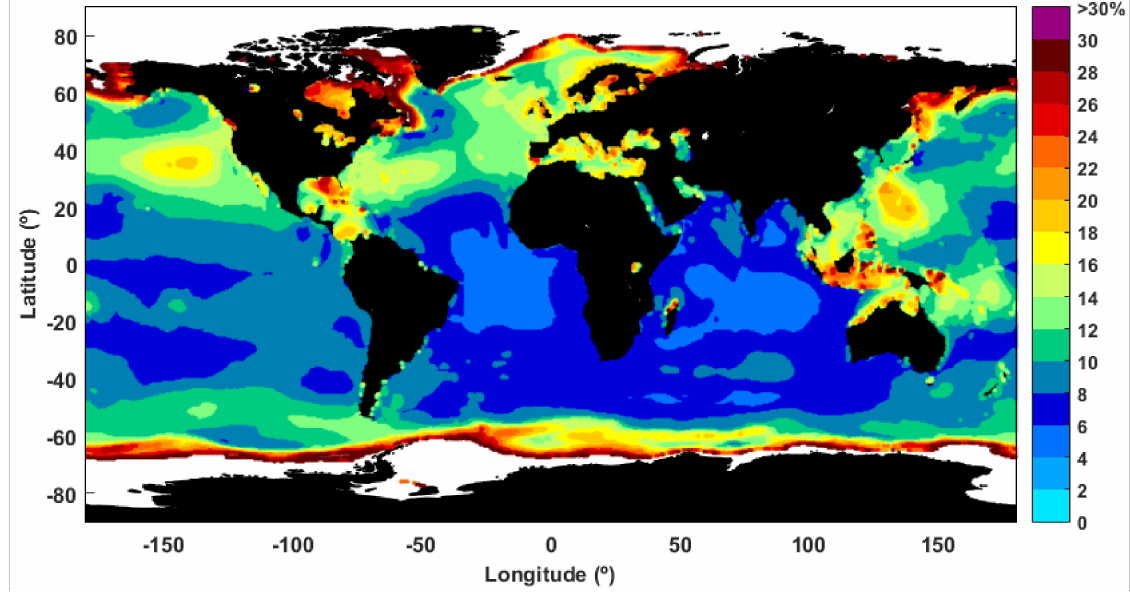
Figure 4. Inter-annual variability (IAV) for ERA5 wave power over the 30-year time interval